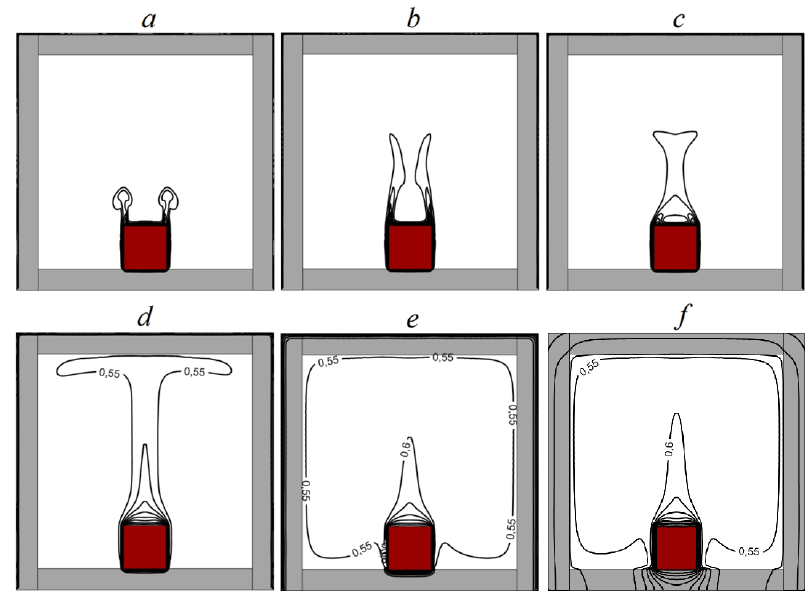
Figure 4. Isotherms Θ at Ra = 10 9 , Os = 1, (cid:101) = 0.3: ( a ) τ = 3, ( b ) τ = 10, ( c ) τ = 15, ( d ) τ = 50, ( e ) τ = 200, and ( f ) τ = 2000.